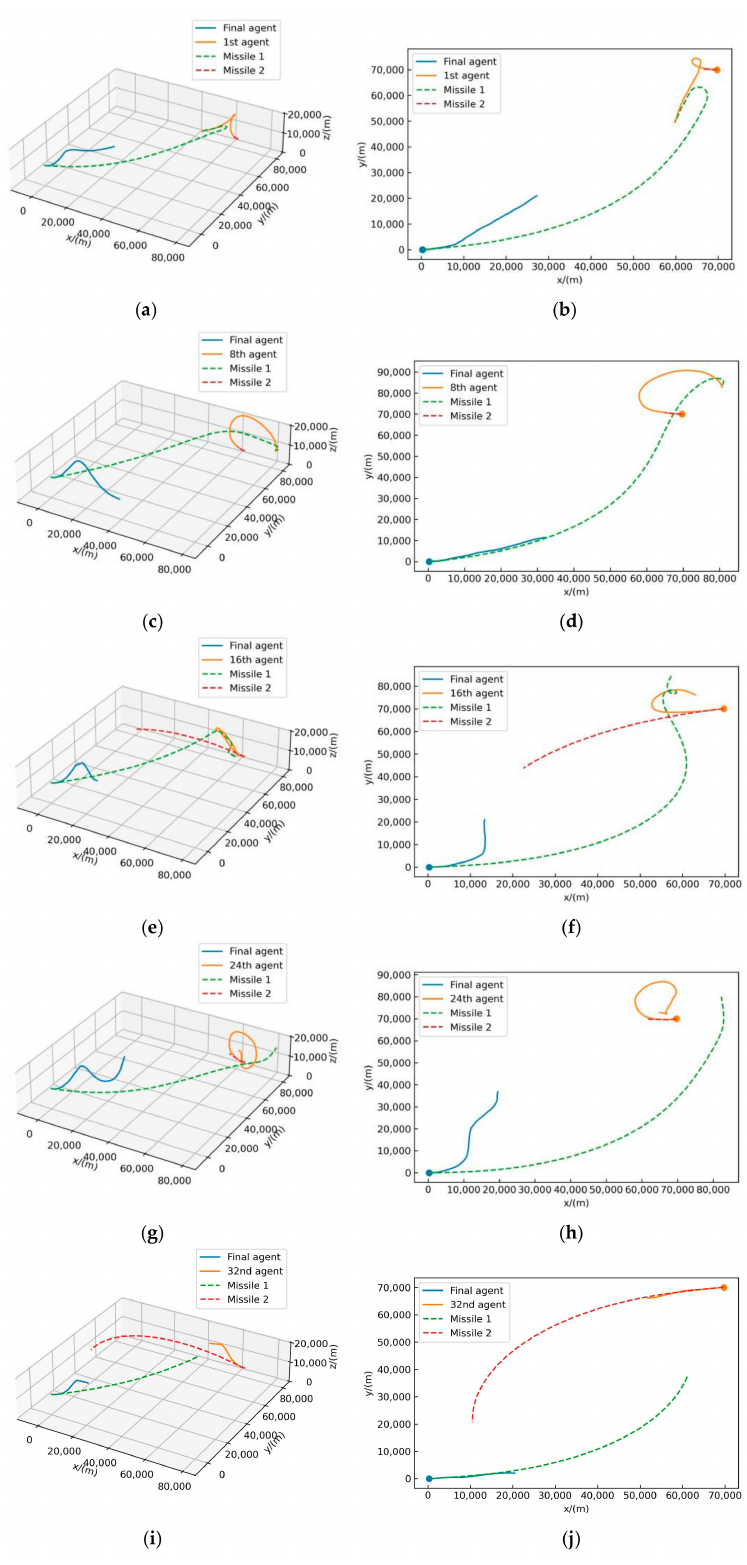
Figure 5. Comparison of Training Results of Different Iterations. ( a ) The 3D trajectory of the first agent. ( b ) Top view of the trajectory of the first agent. ( c ) The 3D trajectory of the eighth agent. ( d ) Top view of the trajectory of the eighth agent. ( e ) The 3D trajectory of the 16th agent. ( f ) Top view of the trajectory of 16th agent. ( g ) The 3D trajectory of the 24th agent. ( h ) Top view of the trajectory of the 24th agent. ( i ) The 3D trajectory of the 32nd agent. ( j ) Top view of the trajectory of the 32nd